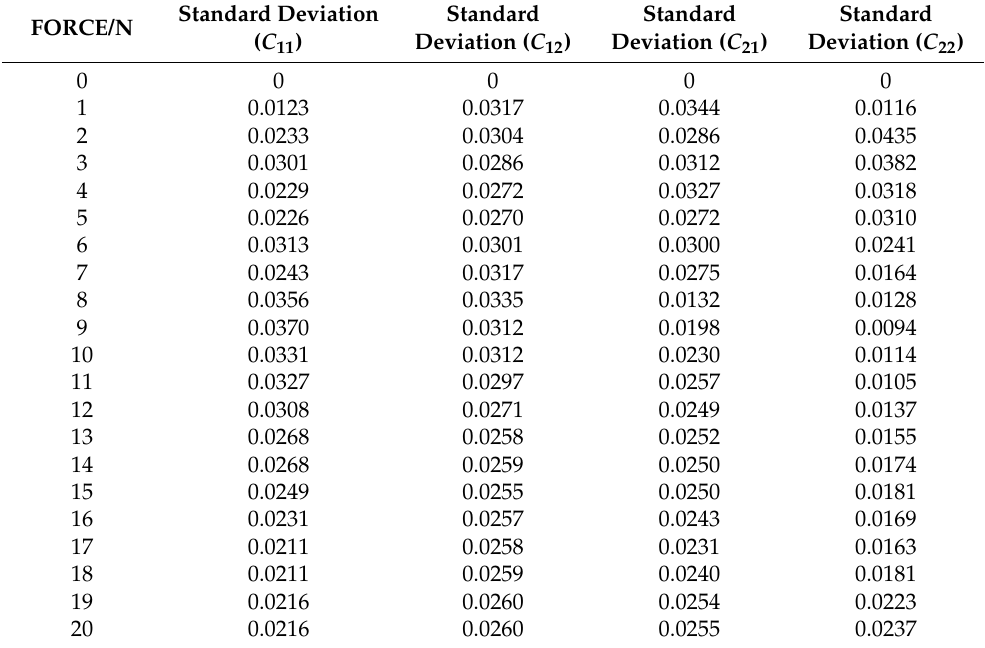
Figure 10. Output characteristic curve of normal force. Table 1. The standard deviation values of the normal force.